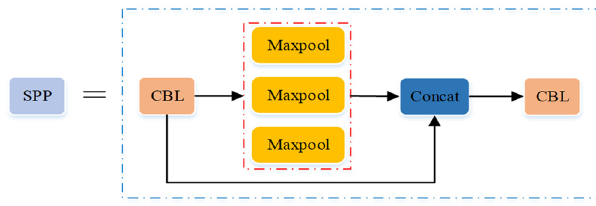
Figure 12. Structure of Spatial Pyramid Pooling ( SPP) module .